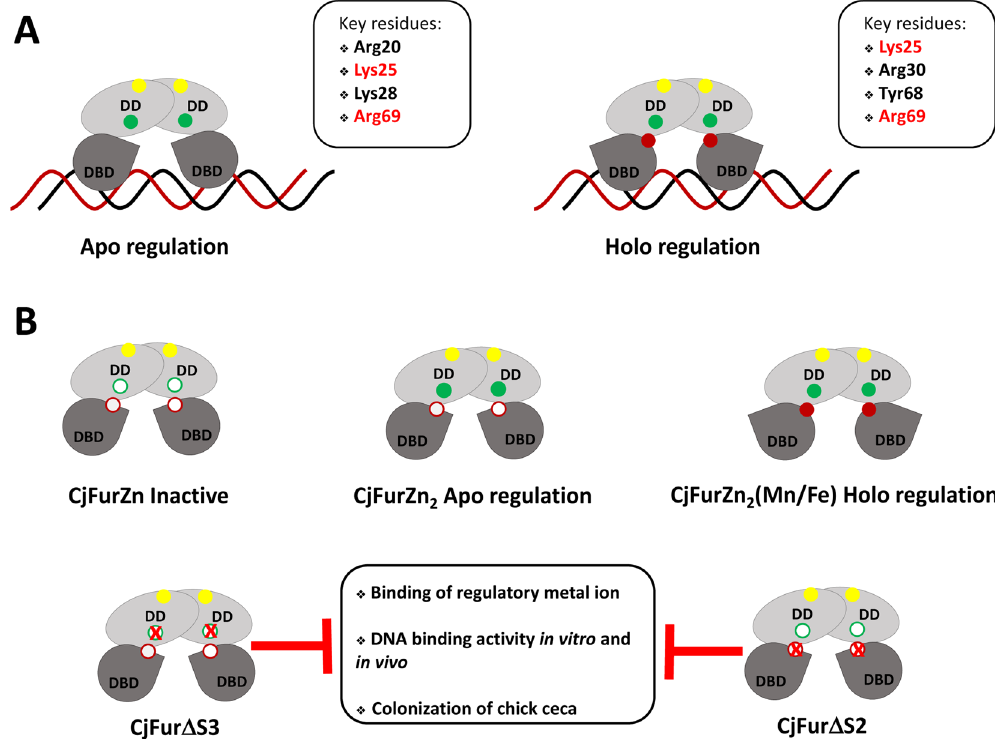
Figure 5. The interplay between the S2 and S3 sites maximize CjFur DNA binding activity. ( A ) Schematic representation of apo-CjFur and holo-CjFur regulation. Key residues important for the gene regulatory activity of CjFur are listed and residues highlighted in red represent residues involved in both apo and holo regulation. Yellow, red and green circles represent S1, S2 and S3 metal binding sites, respectively. ( B ) Schematic representation of different metalation states of CjFur presented in this study. Filled and empty circles indicate metalated and unoccupied metal binding sites, respectively. The red X represent mutated metal binding sites. Mutations of S2 and S3 metal sites result in loss of metal binding in both S2 and S3 sites, decreased DNA binding activity in vitro and in C. jejuni and decreased ability to colonize chick